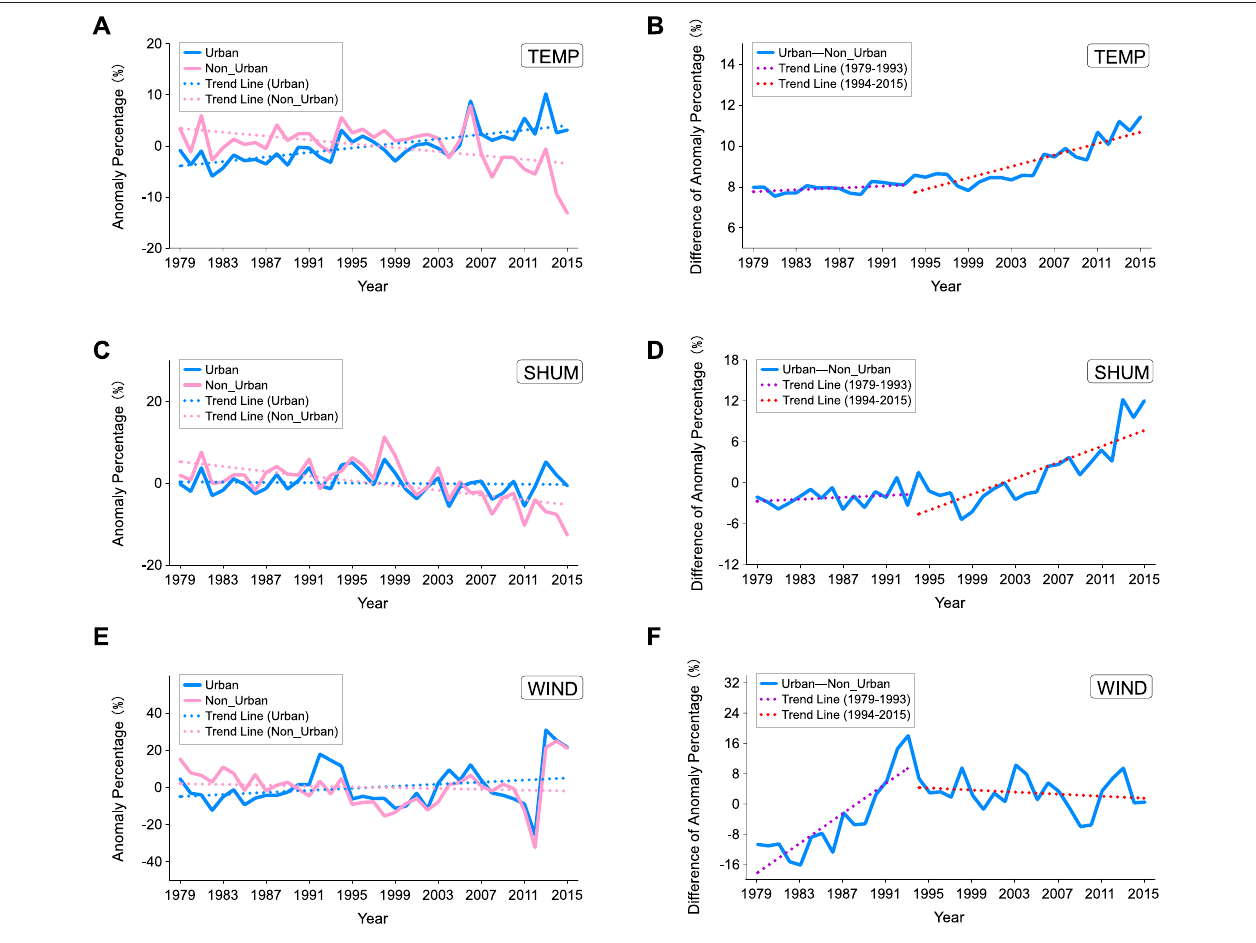
FIGURE 8 | Comparison of annual average temperature (TEMP), speci fi c humidity (SHUM), and wind speed (WIND) in the Sichuan – Chongqing area in urban and non-urban areas between 1979 and 2015: (A,C, and E) show anomaly trends (%), and (B,D, and F) show anomaly differences (%).